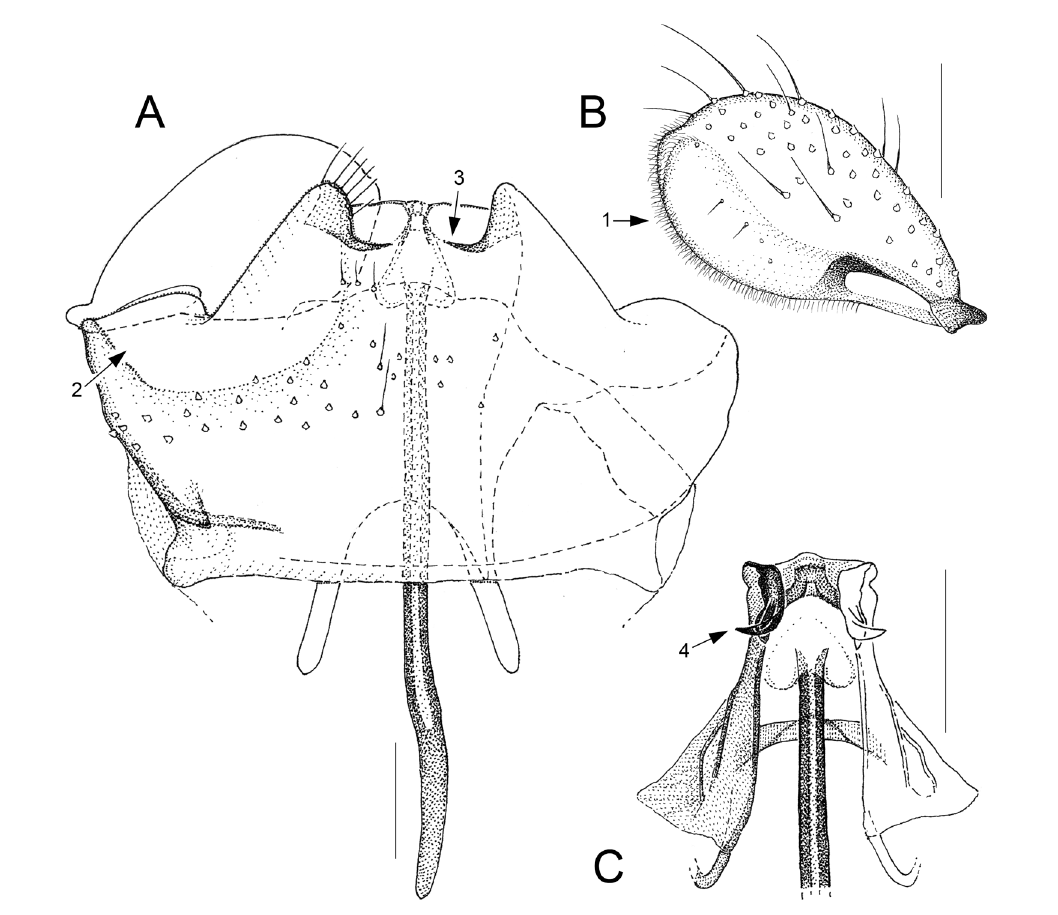
Fig. 4. Glemparon aotearoa sp. nov., holotype, ♂ (NZAC, no. CEC1419). A . Genitalia, ventral. B . Gonostylus, ventral. C . Apex of ejaculatory apodeme and tegmen, ventral. Scale bars = 0.05 mm. Numbered arrows indicate diagnostic characters (see